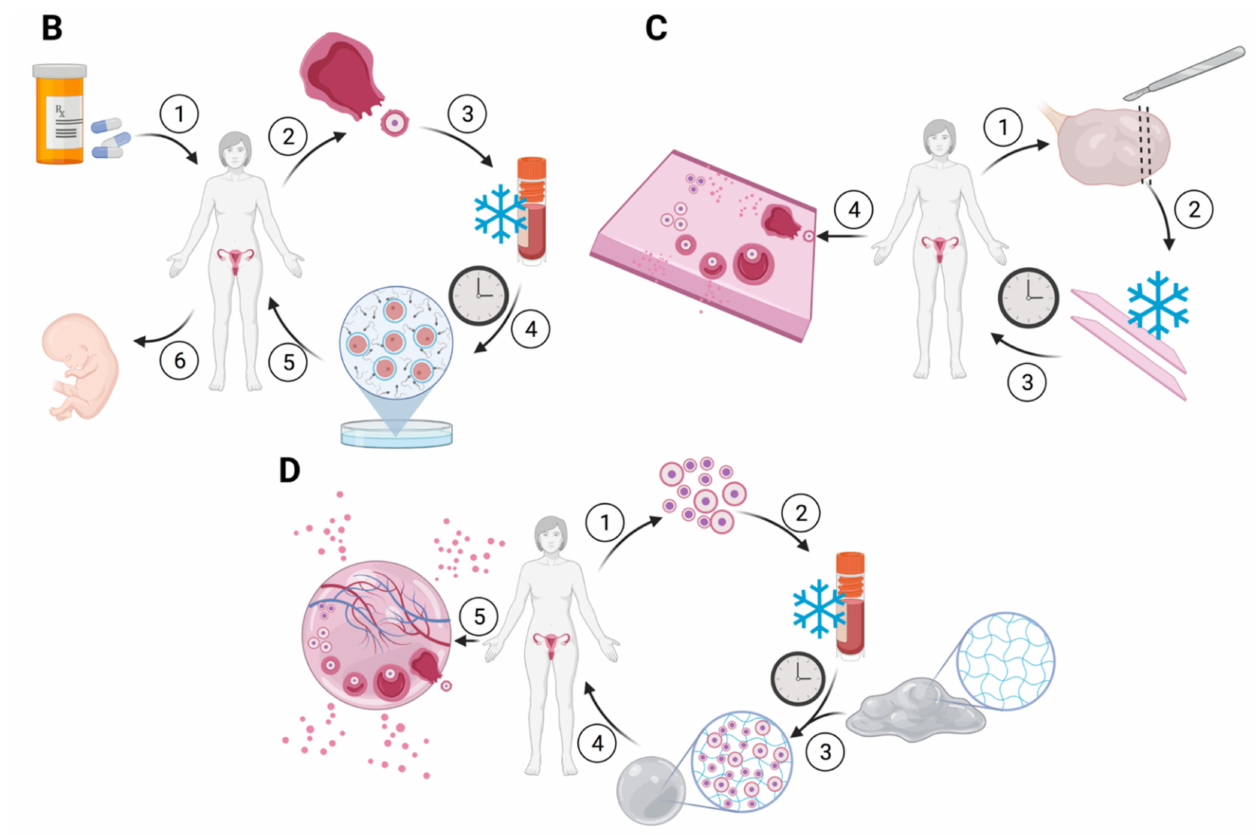
Figure 2. Prospective treatments for ovary failure: ( A ) Histoanatomy of the ovary. Ovulation occurs after follicle maturation triggered by the menstrual cycle. ( B ) In vitro fertilization (IVF) is the current fertility preservation method for women undergoing cancer treatment. Oocytes are harvested after drug-induced ovulation and kept in cryostorage until ready for IVF treatment. ( C ) Ovarian tissue cryopreservation is increasing in prevalence. Thin slices of ovarian tissue are harvested and cryopreserved until after cancer treatment. The tissue is implanted orthotopically for ovary functionality restoration or heterotopically for endocrine restoration and possibility of IVF. ( D ) Tissue engineering could allow ovary replacement. Preantral follicles are harvested and cryopreserved ready for ovary replacement. Hydrogels are generally used as a scaffold to create an artificial organ that can be implanted in situ. Fertility has been restored in murine models along with endocrine function. Numbers indicate procedure order. Figure created with BioRender.com (accessed on 1 June